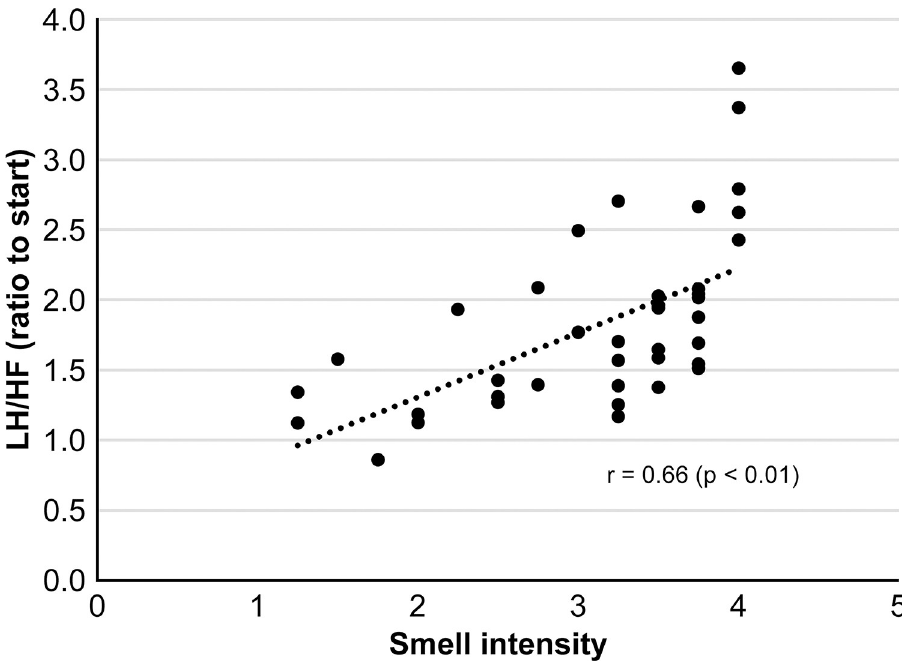
Fig 5. Relationship between the intensity of tension-stress odor and autonomic nervous activity during the interview. A panel of four odor experts evaluated the collected skin-gas samples to compare differences between those emanated during stress and at baseline. From all interview samples, we discovered a characteristic odor resembling stir-fried leek. The intensity of this characteristic odor was positively correlated with the rate of increase in sympathetic nerve activity during the interview compared with before the interview (Spearman’s correlation coefficient: r = 0.66 ( p < 0.01)).